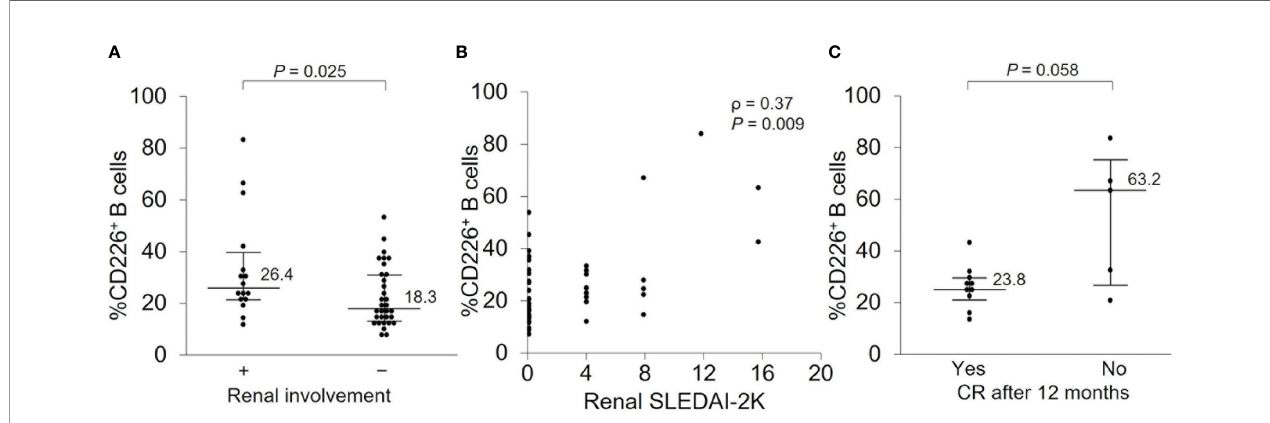
FIGURE 5 | CD226 + B cells at baseline and renal prognosis after 12 months . (A) The frequency of CD226 + B cells was compared between SLE patients with renal involvement and those without. (B) Correlation between the percentage of CD226 + B cells and renal SLEDAI-2K scores. (C) In patients with renal involvement at baseline, the percentage of CD226 + B cells was compared between patients who achieved complete renal remission (CR) after 12 months and those who did not. Each data point represents a single subject. Horizontal lines show the median and error bars represent interquartile ranges. Statistical differences among groups were evaluated using the Mann – Whitney U test. Correlation analyses were evaluated using Spearman ’ s rank correlation. SLEDAI-2K, SLE Disease Activity Index